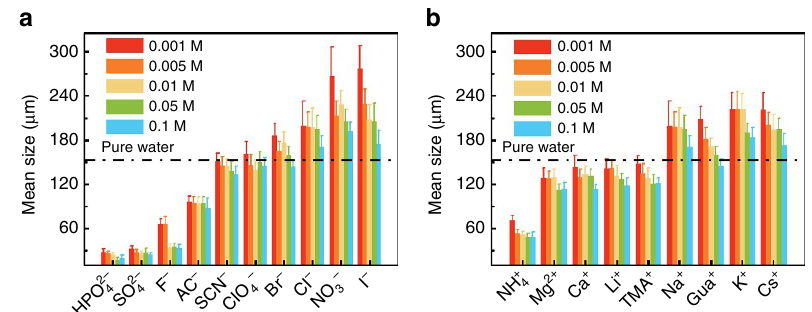
Figure 2 | Effect of ions on tuning ice recrystallization. ( a ) The effect of anions in tuning the ice crystal size. Na þ was used as the common counter-ion. ( b ) The effect of cations in tuning the ice crystal size. Cl (cid:2) was used as the common counter ion. Five concentrations were tested for each ion. The mean grain sizes obtained from aqueous solutions of different ions were measured after the polycrystalline ice was annealed at (cid:2) 6 (cid:2) C for 45min, while the initial quench temperature was (cid:2) 60 (cid:2) C. Error bars represent the s.d. of the size of thirty ice crystals. The dash-dot line is the mean grain size from pure water